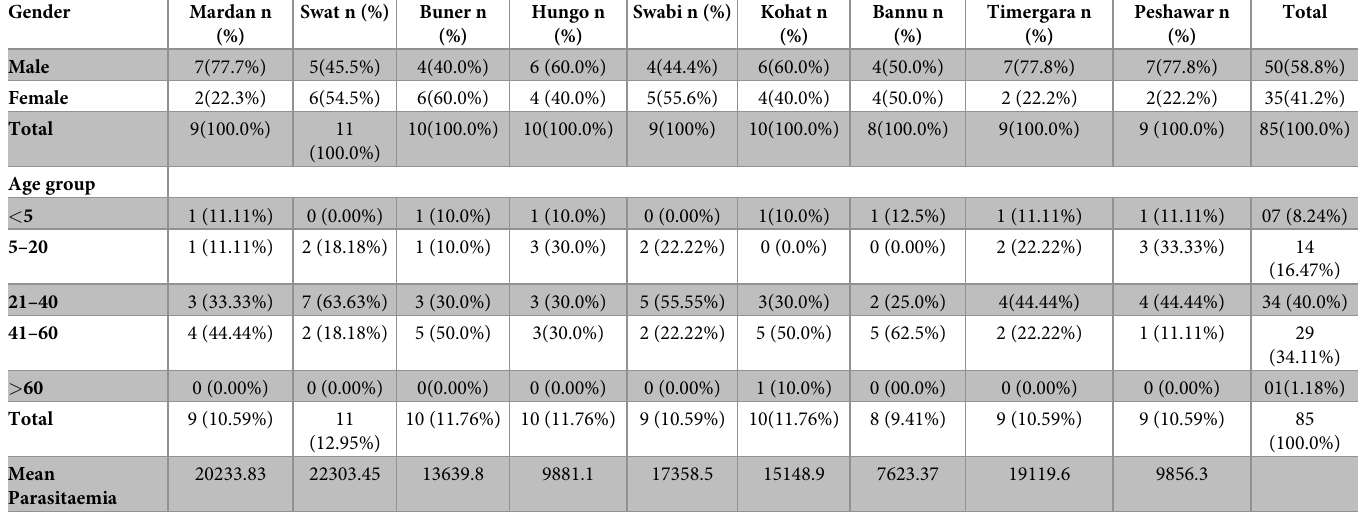
Table 2. Population characteristics of P . falciparum infected patients in the study